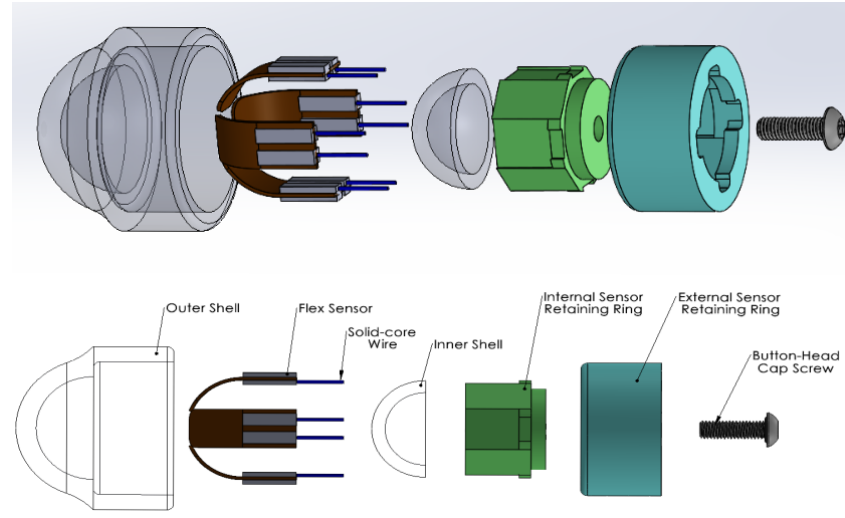
Figure 3. Sensor exploded view and labeled components.